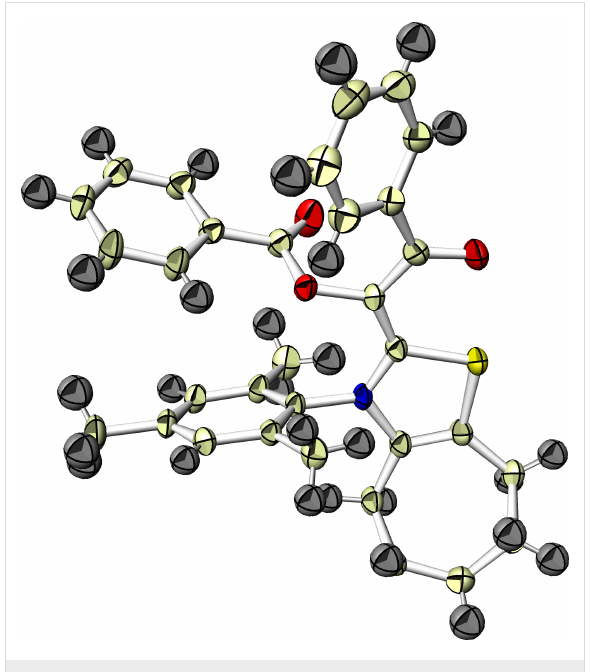
Figure 2: ORTEP drawing of 10